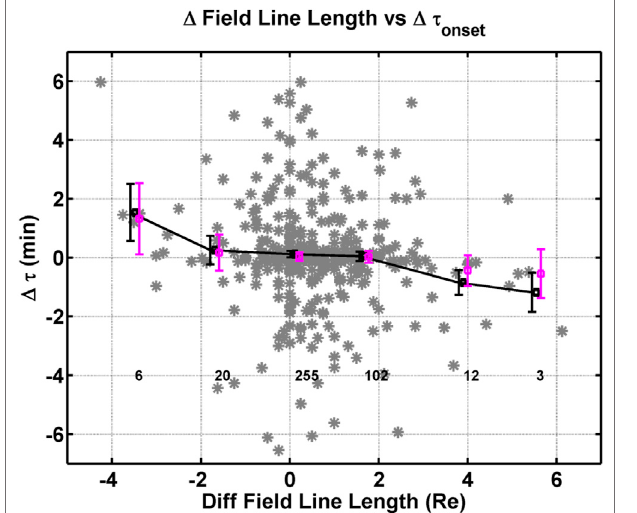
FIGURE 8 | Difference in onset time versus season (day of year). The gray points are the individual events, the black squares are means of bins 90 days wide, and the mauve squares are medians of bins 90 days wide. The number of points per bin is given at the base of the plot. The error bars areerrorsofthemeanandmedians.Theblueverticallinesmarktheequinoxes and the solstices. The red curve is a sine wave fi t to the black